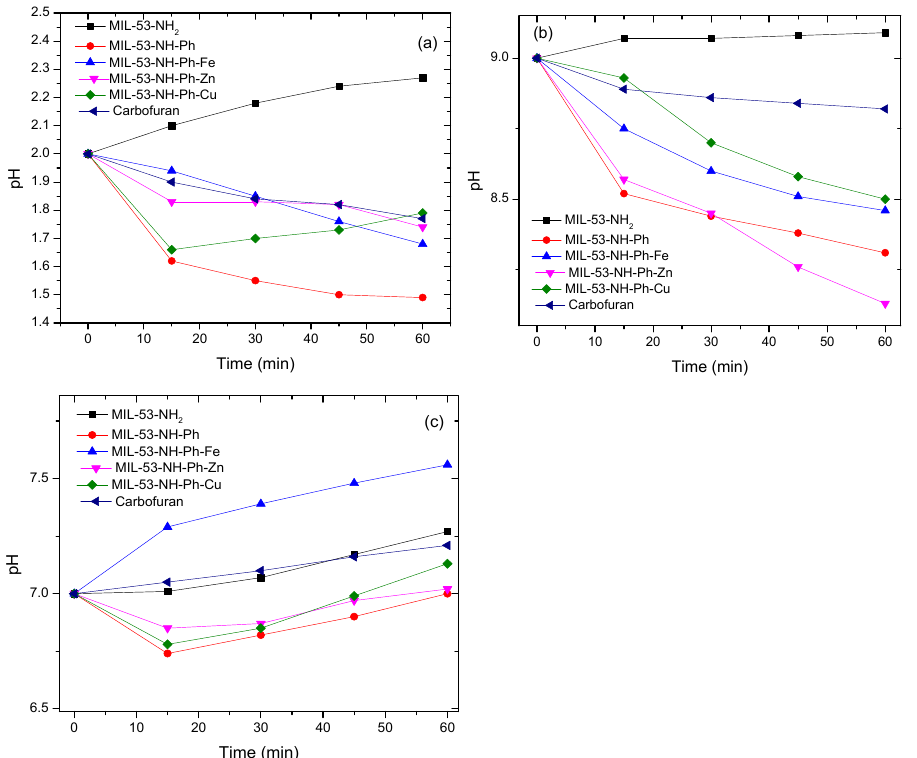
Figure 6. ( a ) Change in pH 2 profile (acidic medium) with time in the presence of MIl-53-NH 2 , MIL-53-NH-ph, MIL-53-NH-ph-Fe, MIL-53-NH-ph-Zn, MIL-53-NH-ph-Cu, and carbofuran, ( b ) Change in pH 9 profile (basic medium) with time in the presence of MIl-53-NH 2 , MIL-53-NH-ph, MIL-53-NH-ph-Fe, MIL-53-NH-ph-Zn, MIL-53-NH-ph-Cu, and carbofuran, ( c ) Change in pH 7 profile (neutral medium) with time in the presence of MIl-53-NH 2 , MIL-53-NH-ph, MIL-53-NH-ph-Fe, MIL-53-NH-ph-Zn, MIL-53-NH-ph-Cu, and carbofuran.